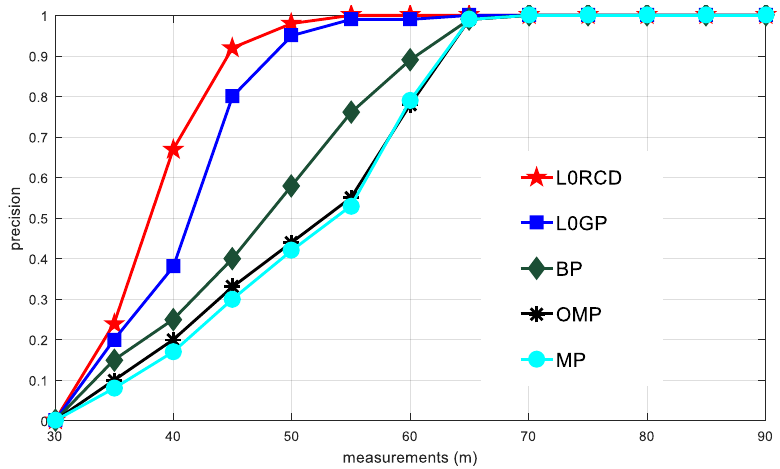
Figure 11. Precision comparison of the five algorithms (changed measurements).